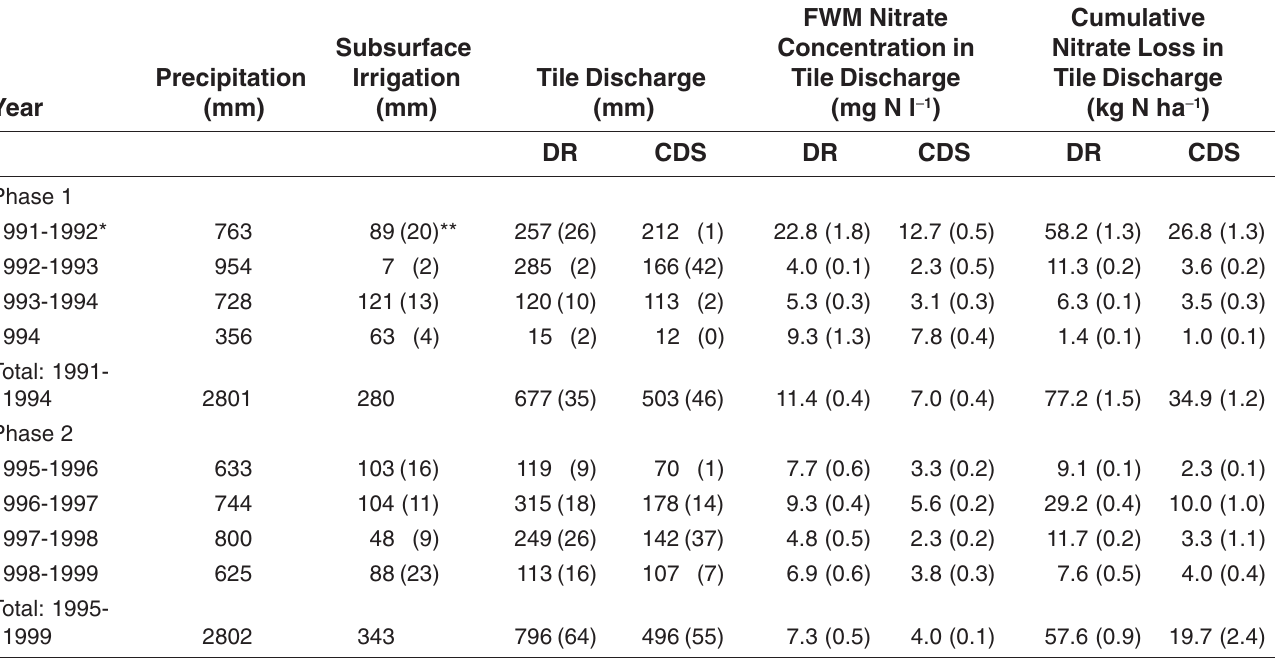
Precipitation, Subsurface Irrigation Volumes for the CDS Treatment, Tile Discharge, FWM Nitrate Concentrations, and Cumulative Nitrate Loss in Tile Discharge for the DR and CDS Treatments during Phase 1 (Continuous Corn) and Phase 2 (Soybean-Corn